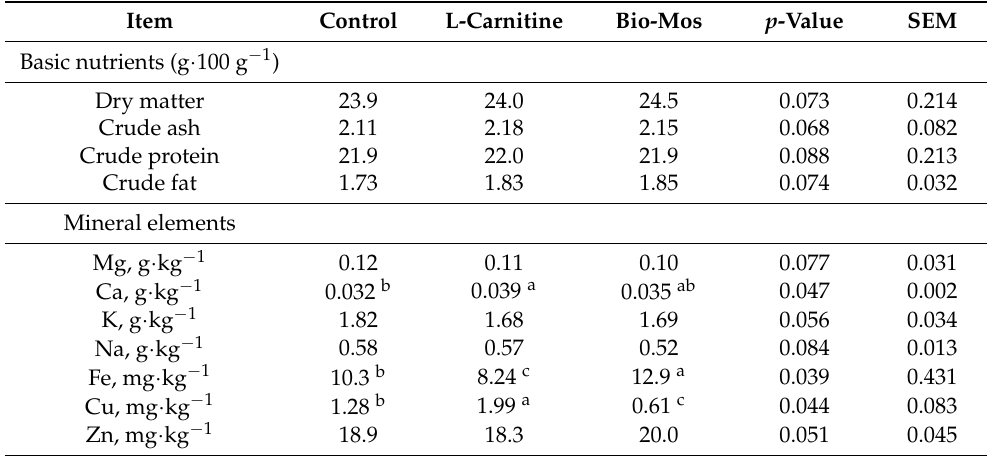
Table 6. Content of basic nutrients and mineral elements in female turkey’s thigh muscle 1 .